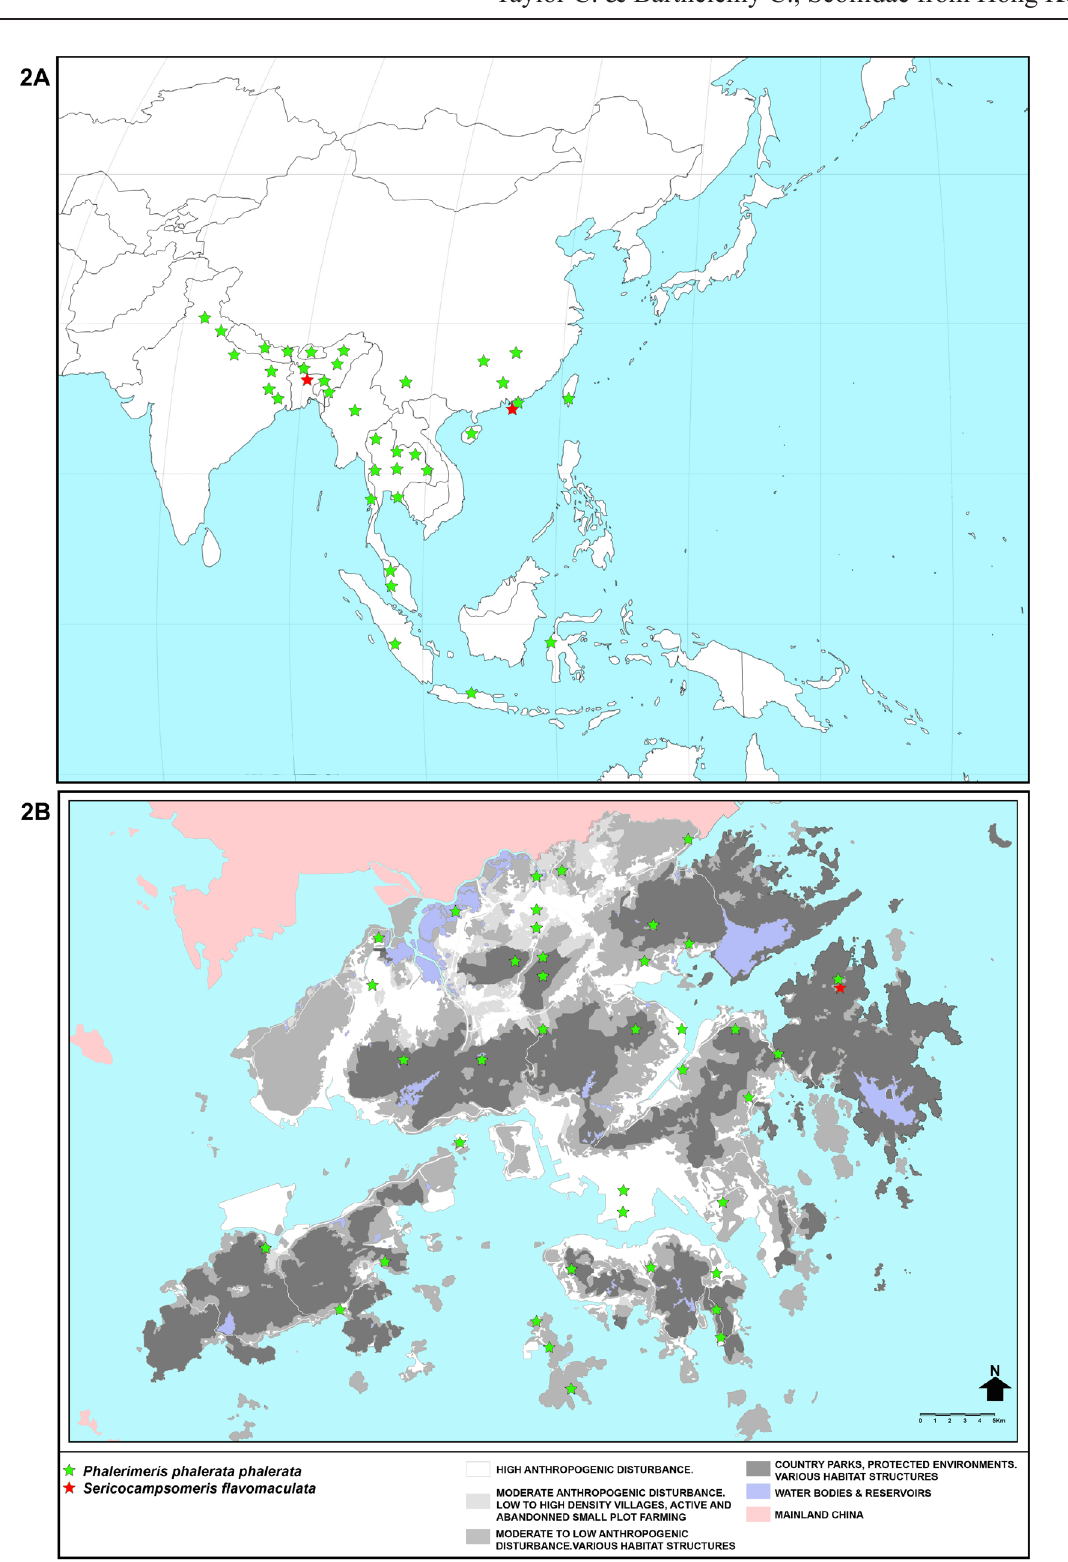
Fig. 2. Distribution of two species in the tribe Campsomerini Bartlett, 1912: Phalerimeris phalerata phalerata (de Saussure, 1858) and Sericocampsomeris flavomaculata Gupta & Jonathan, 1989. A . World distribution. B . Hong Kong